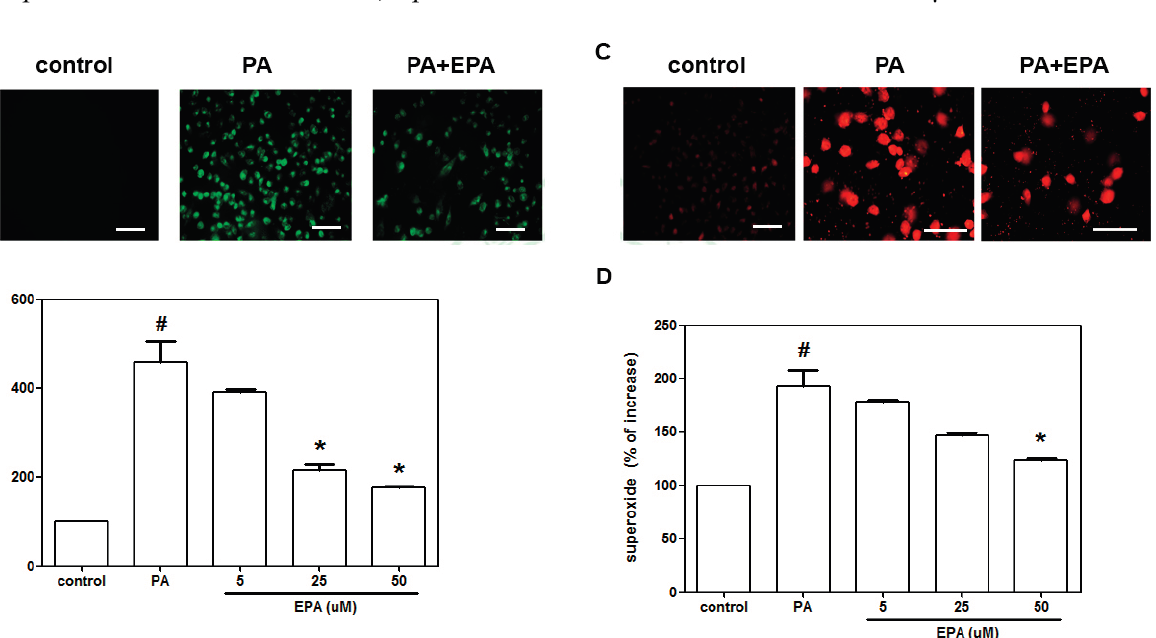
Figure 2. The protective effects of EPA on PA-induced ROS and superoxide generation in HUVECs. After pretreatment for 2 h with the indicated concentrations of EPA (5–50 μ M), the HUVECs were incubated with DCF-AM or DHE for 1 h, followed by treatment with PA (0.5 mM) for 2 h in the presence of EPA. Fluorescence images indicating the ROS ( A ) and superoxide levels ( C ) in the controls ( left ) and the cells that were stimulated with PA ( middle ) in the presence of 50 μ M EPA ( right ); The fluorescence intensities of the HUVECs were determined using a fluorescence microplate reader. The fluorescence distributions of DCF-AM oxidation ( B ) and DHE ( D ) expressed as percentage increases in intensity. The data are expressed as the means ± the S.E.s of five independent